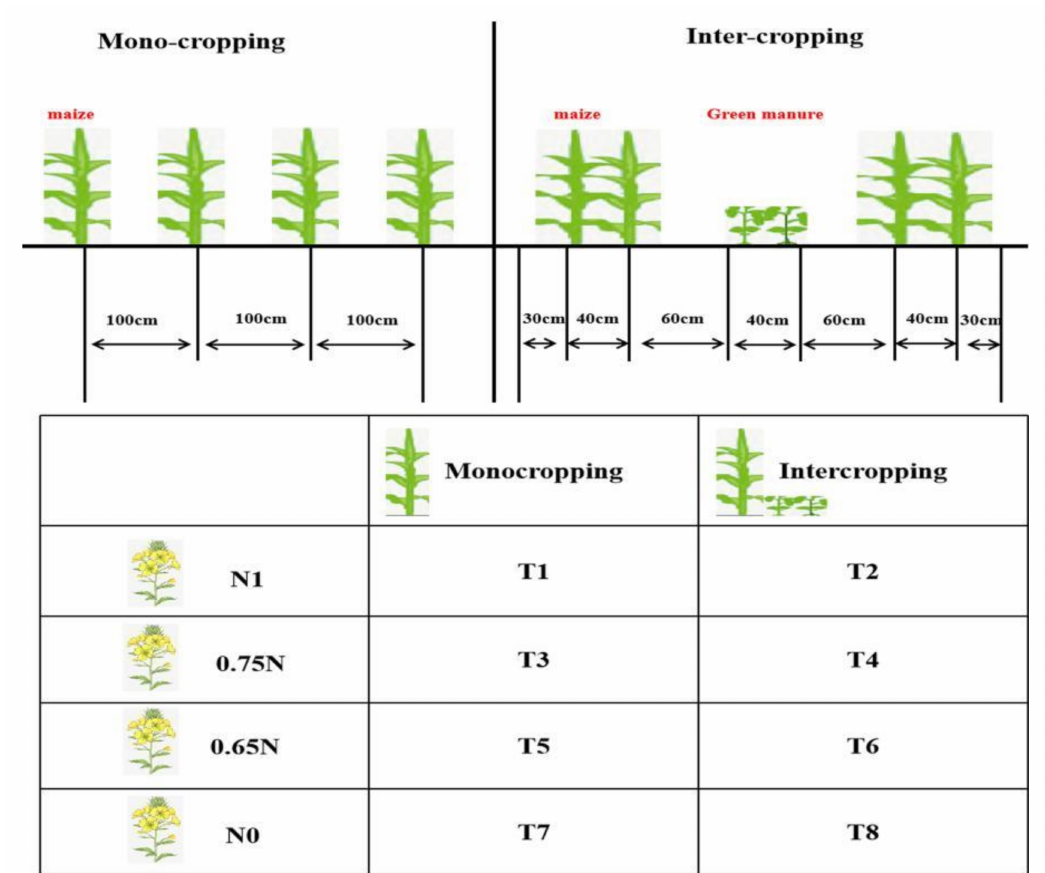
Figure 5. Schematic diagram of maize planting mode and treatment design. Note: T1, T3, T5, T7 represents maize monocropping combined with 100%, 75%, 65%, 0 nitrogen doses in oilseed rape, respectively; T2, T4, T6, T8 represents maize intercropping combined with 100%, 75%, 65%, 0 nitrogen doses in oilseed